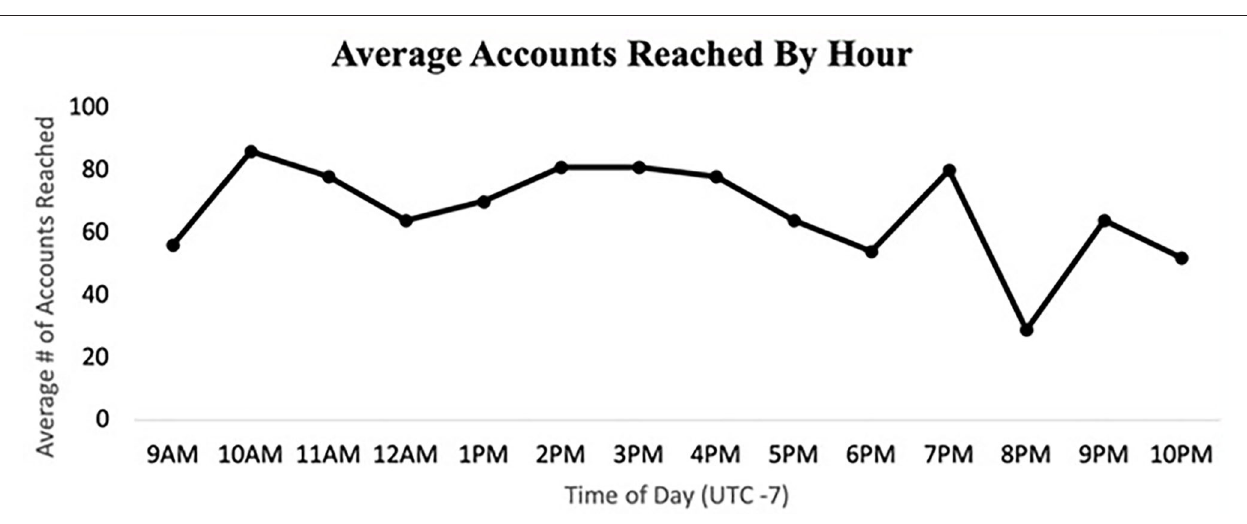
FIGURE 5 | Average accounts reached by an